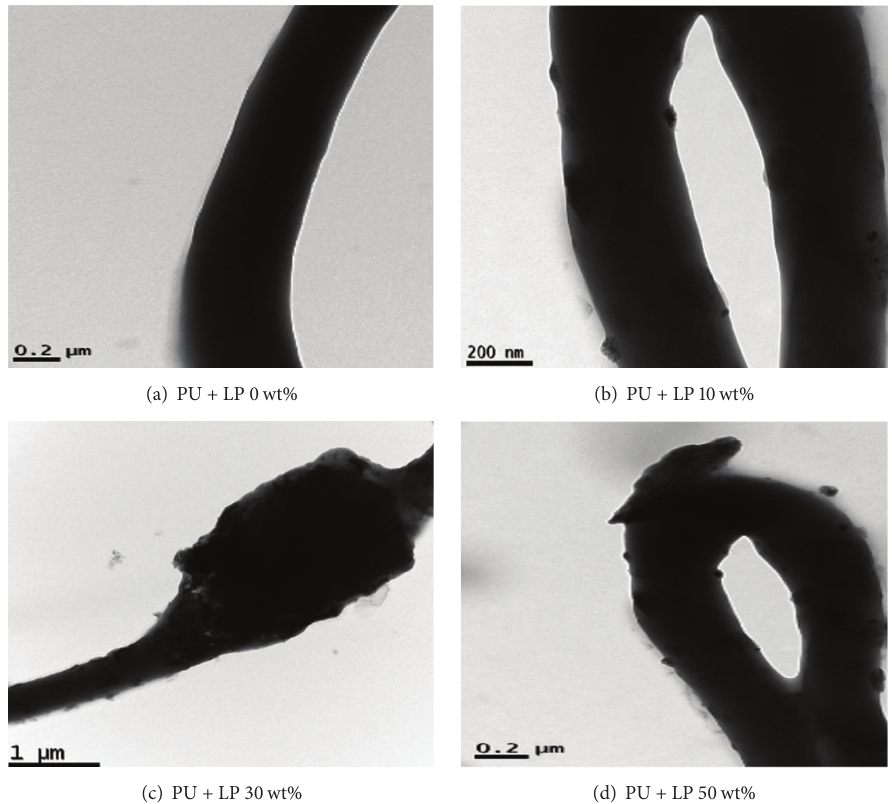
Figure 3: TEM images of PU/LP electrospun fibers containing 0, 10, 30, and 50 wt% LP.